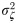
Information propagation through spike-generating nonlinearities with additive input noise.As with Fig 5, responses in the second layer were generated using the dichotomized model of spike generation, in which the input from the first layer was simply binarized. Here, though, Gaussian noise was added before thresholding; see Eq (13). We varied the correlations in the input layer (see Eq (12)) while keeping the input information and input tuning curves fixed for the 100-cell population (same tuning curves and covariance matrices as in Fig 5). The additive noise at the second layer (the ζi) was iid Gaussian, with variance σζ2; different colored lines correspond to different values of σζ2. (A) Output information versus ϵu for populations with differential correlations (u = f′(s)). (B) Same as panel A, but for populations that concentrate noise along an axis, u, that makes an angle of 0.1 rad with the f′(s) direction. For both panels, the input information was held fixed as ϵu was varied, and the information was averaged over 20 evenly spaced stimuli.